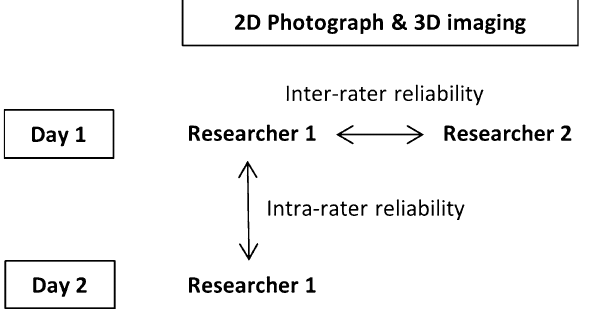
Figure 1. Schematic diagram of the study design. On the first day, 2D photograph and 3D imaging were taken for each subject by two reserchers. On another day, both 2D, 3D images were taken by researcher 1.